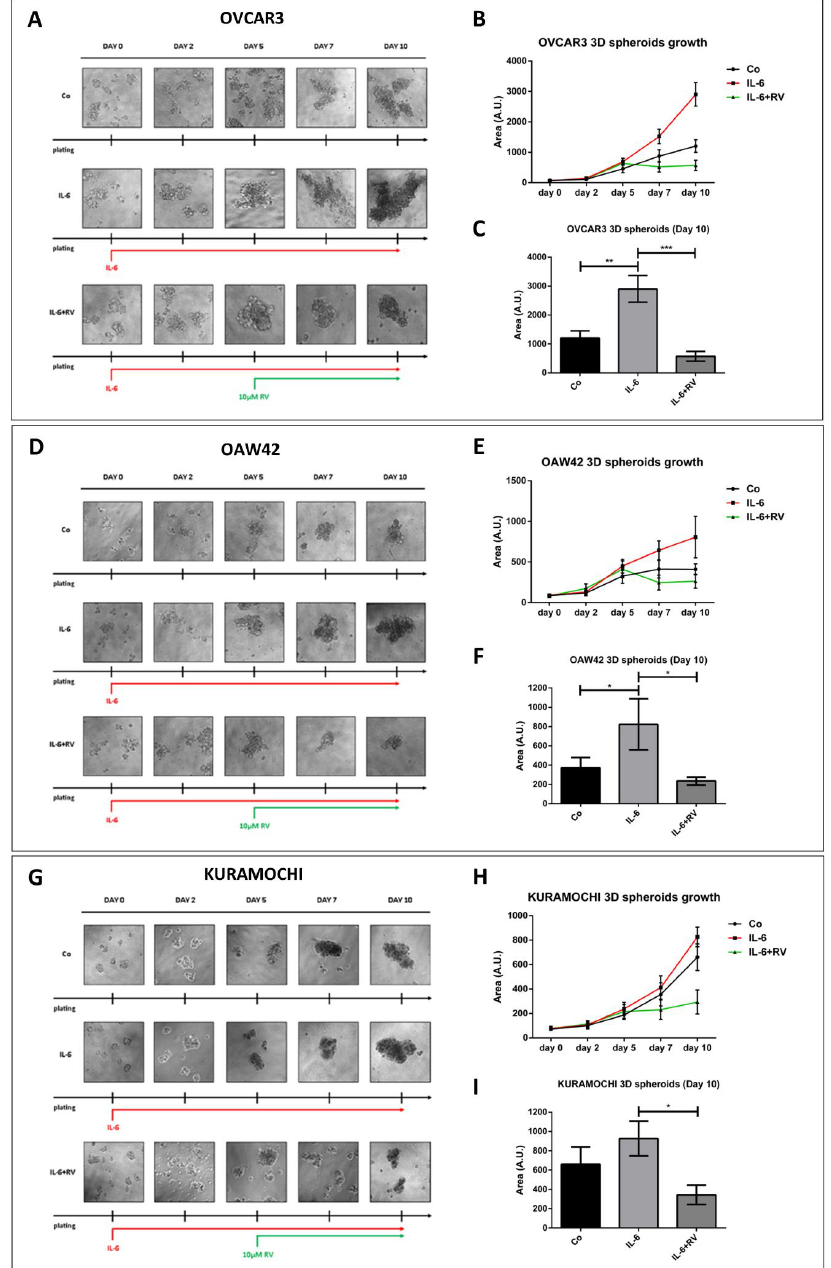
Figure 1. Resveratrol contrasts the IL-6-induced growth of 3D ovarian cancer cell spheroids. OVCAR3, OAW42, and KURAMOCHI cells were grown as 3D spheroids on non-adherent Petri dishes. On day 0, cells were incubated with 50 ng/mL IL-6 and re-treated on days 2, 5, and 7. 10 µ M RV was added on days 5 and 7 in combination with IL-6. 3D spheroid dimensions were determined with ImageJ software. Data represent the average S.D. calculated for three different fields per condition ± in three separate experiments. ( A , D , G ) Time-course phase-contrast photos of OVCAR3, OAW42, and KURAMOCHI 3D spheroids. ( B , E , H ) Growth curve representing the 3D spheroid dimensions of OVCAR3, OAW42, and KURAMOCHI during the experimental timeline. ( C , F , I ) Quantification of 3D area on day 10 of OVCAR3, OAW42, and KURAMOCHI spheroids. Statistical analysis was performed by using GraphPad Prism 5.0 software. Bonferroni’s multiple comparison test after one-way ANOVA was employed. Significance was considered as follow: *** p < 0.001; ** p < 0.01; * p <